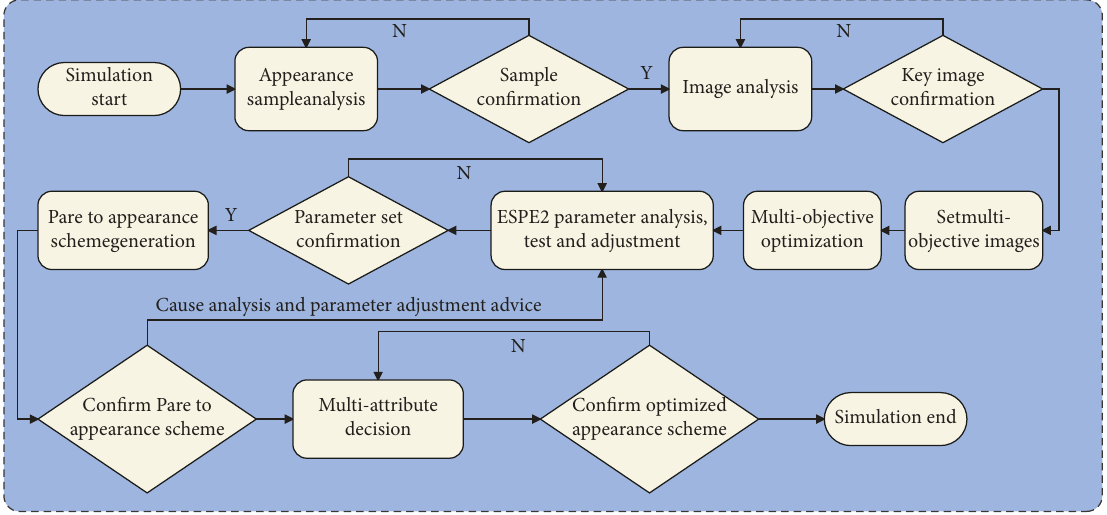
Figure 4: Application process of the simulation system.